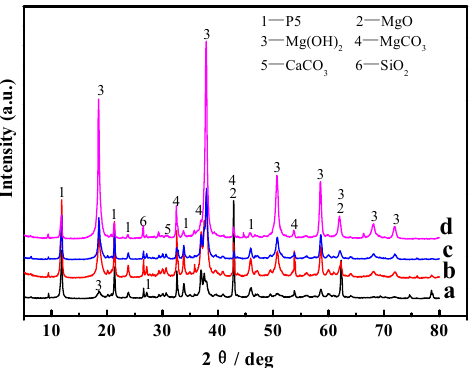
Figure 10. XRD patterns of the surface layers of the MOC samples after different dry–wet cycles: (a) without dry–wet cycles; (b) one time; (c) two times; (d) three times.